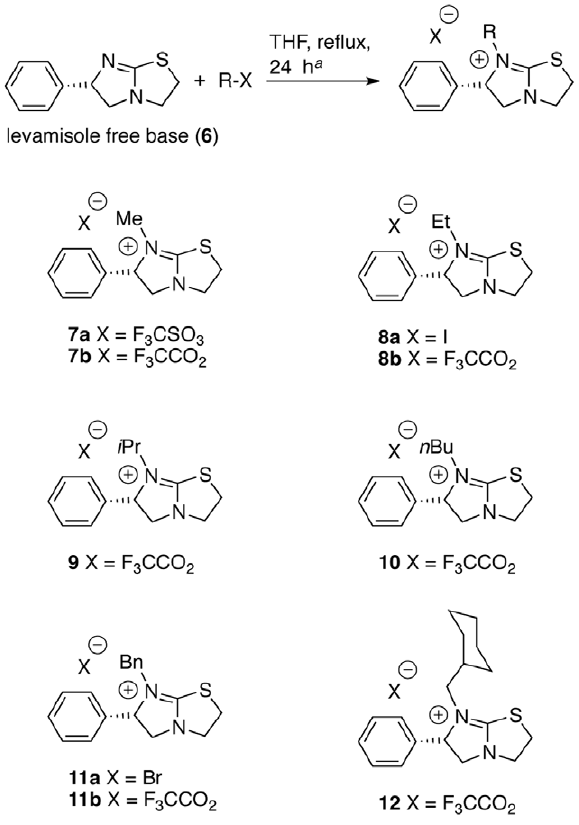
Figure 4. Structures of the N-alkylated analogues of levamisole synthesized and tested in this study. a Standard conditions applied for all compounds except the N -methylated analogue 7a , which was furnished by treatment with methyltriflate in diethylether for 2 h at room temperature as previously described [50].